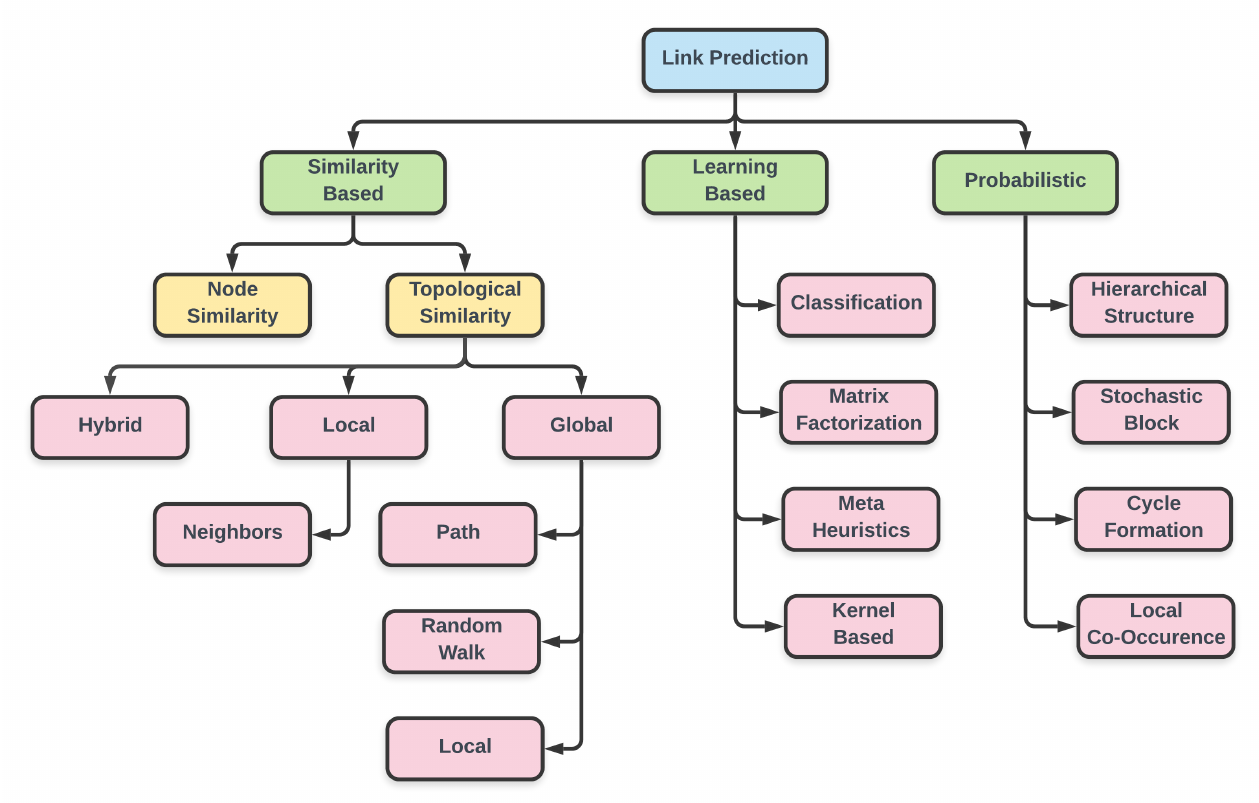
Figure 2. Link Prediction